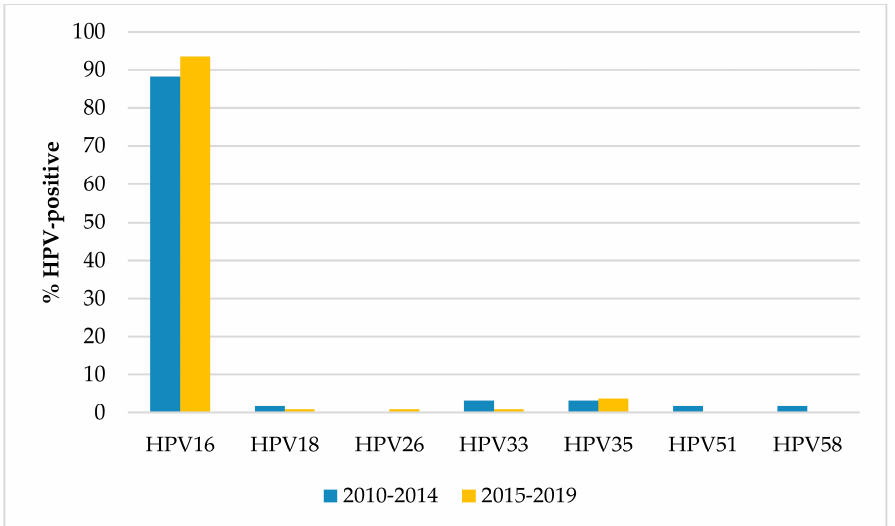
Figure 1. Prevalence of the individual HPV genotypes among the HPV-positive oropharyngeal squamous cell carcinomas according to the period of diagnosis.